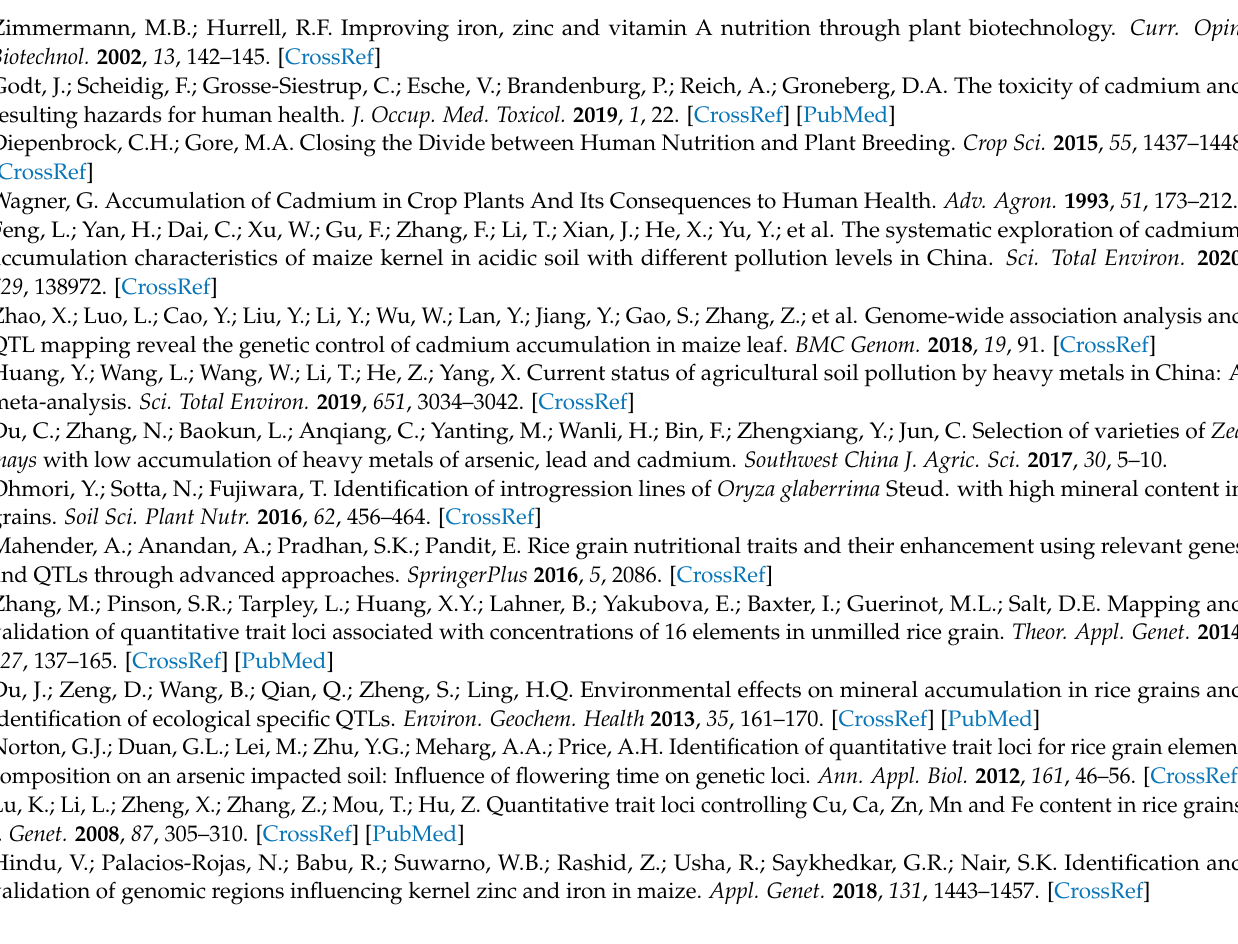
Table S2: The maize inbred with higher contents of Fe, Zn, Cu, Mn and less content of As and Cd.; Table S3: SNPs associated with Cd accumulation in maize kernel, of which the p -value was less than 10 − 8 .; Table S4: Correlation of the contents of Fe, Zn, Cu, Mn, As and Cd in maize kernel compared to